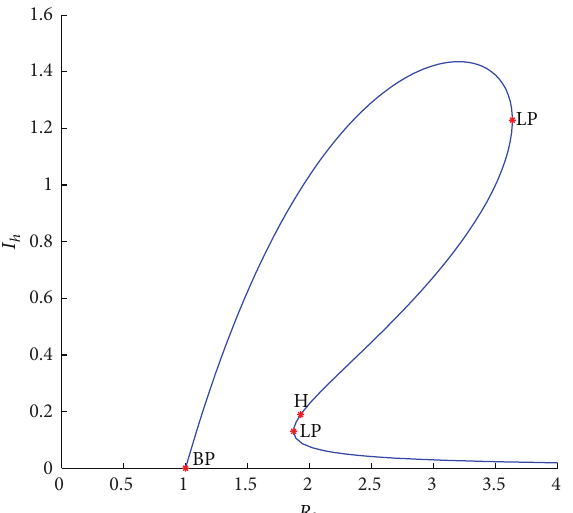
Figure 3: Bifurcation curves in (𝑅 0 , 𝐼 ℎ ) plane when 𝑟 = 0.8 , 𝐾 = 10 , = 1 , 𝑎 = 1 , 𝑎 = 0.3 , 𝑑 𝛽 1 1 2 = 0.06 , 𝛽 = 0.26 , and 𝑁 𝑑 V 2